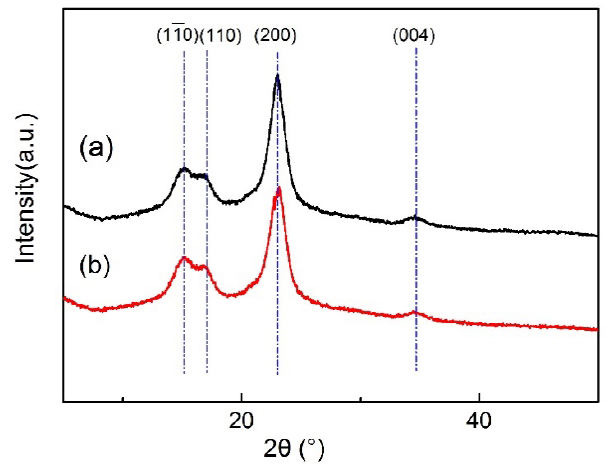
Figure 7. XRD patterns: ( a ) CF; ( b ) CF-TiO 2 .